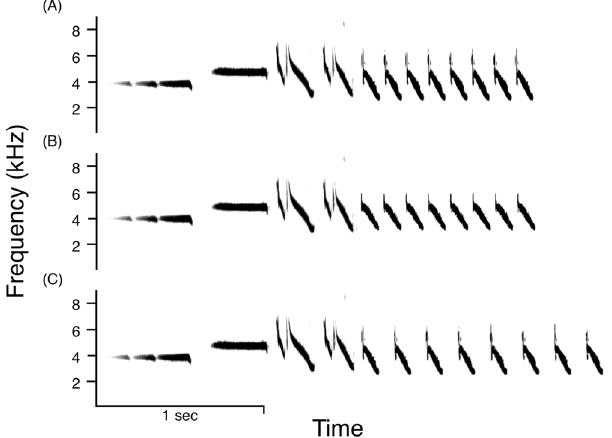
Figure 1. Example stimulus set of ( A ) fast trill, wide bandwidth song, ( B ) fast trill, narrow bandwidth song, and ( C ) slow trill, wide bandwidth song.